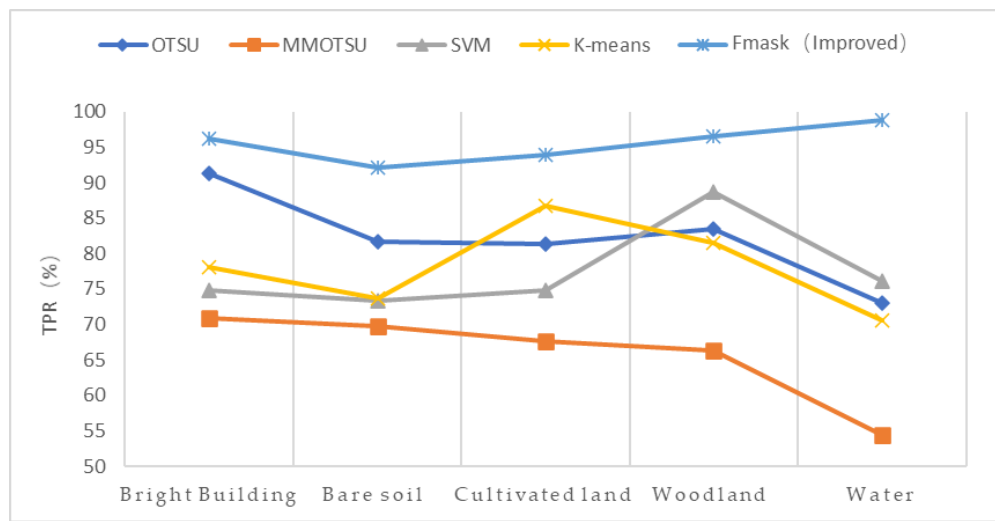
Figure 12. Comparison of the TPR of detecting cloud pixels by different